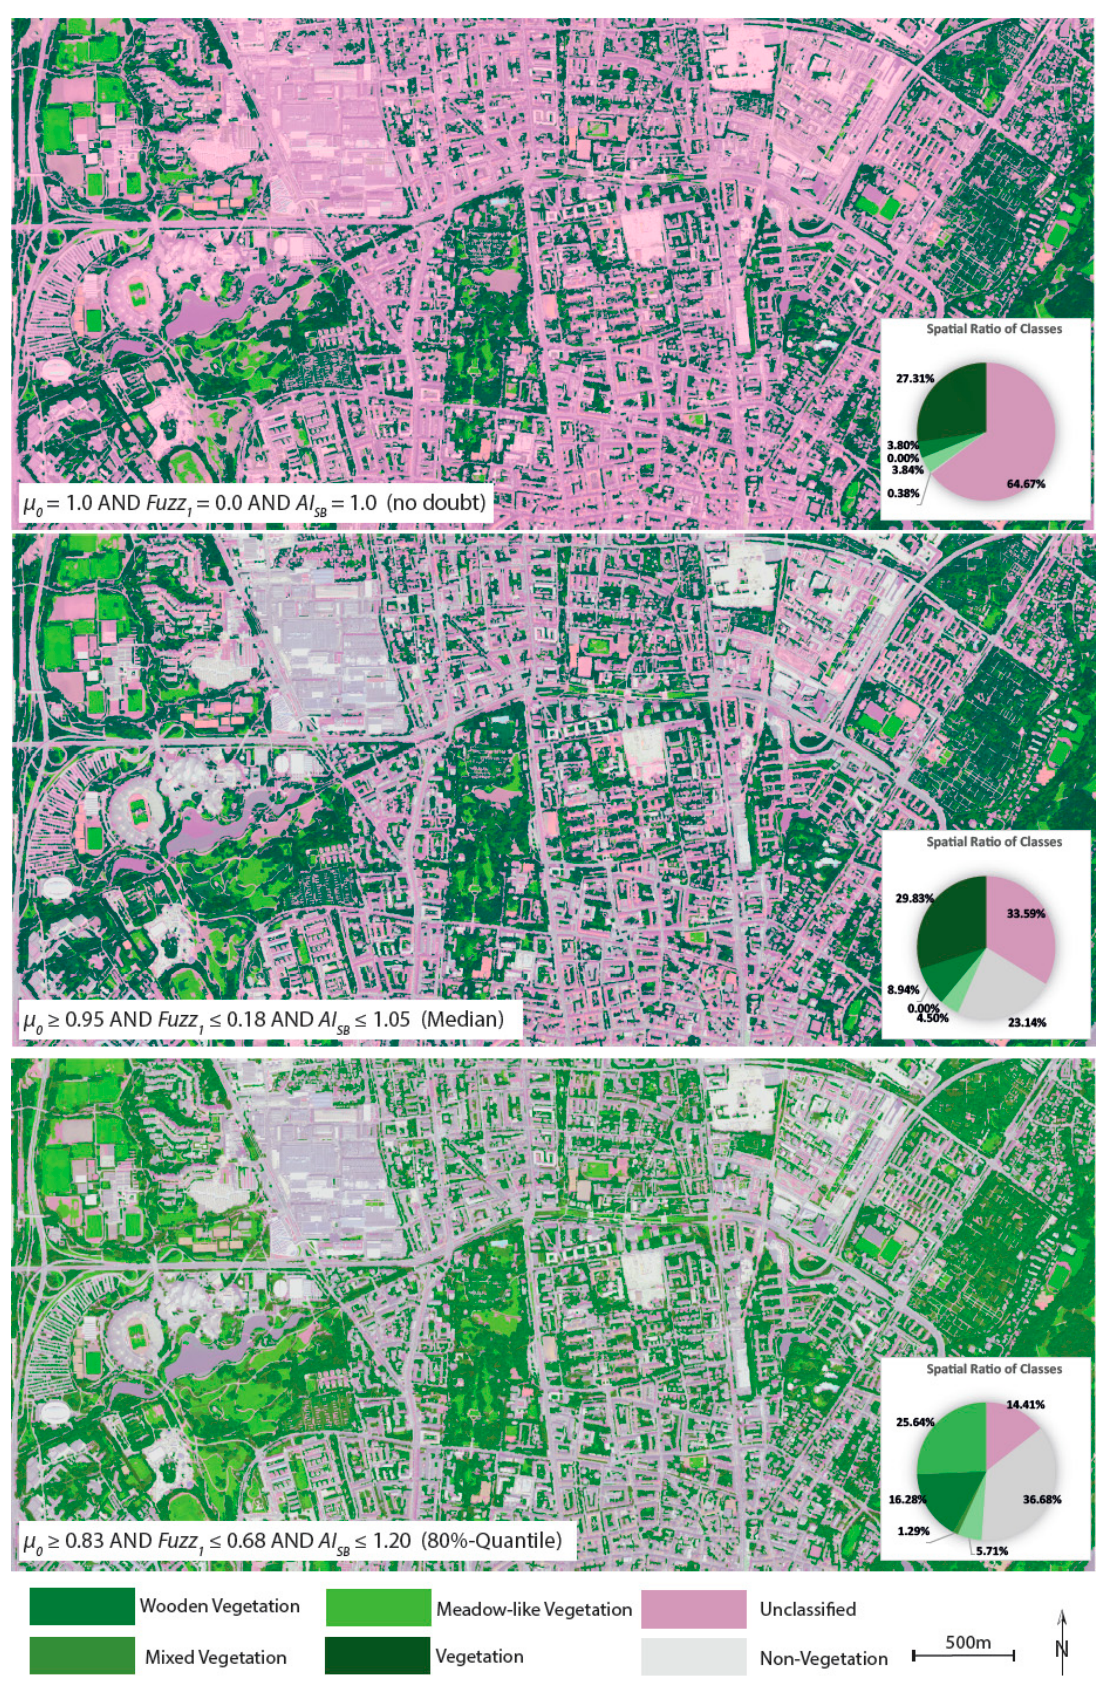
Figure 12. Crisp re-classifications of previously unclassified objects following defuzzification according to the defuzzification rules outlined in the text and indicated in each image.